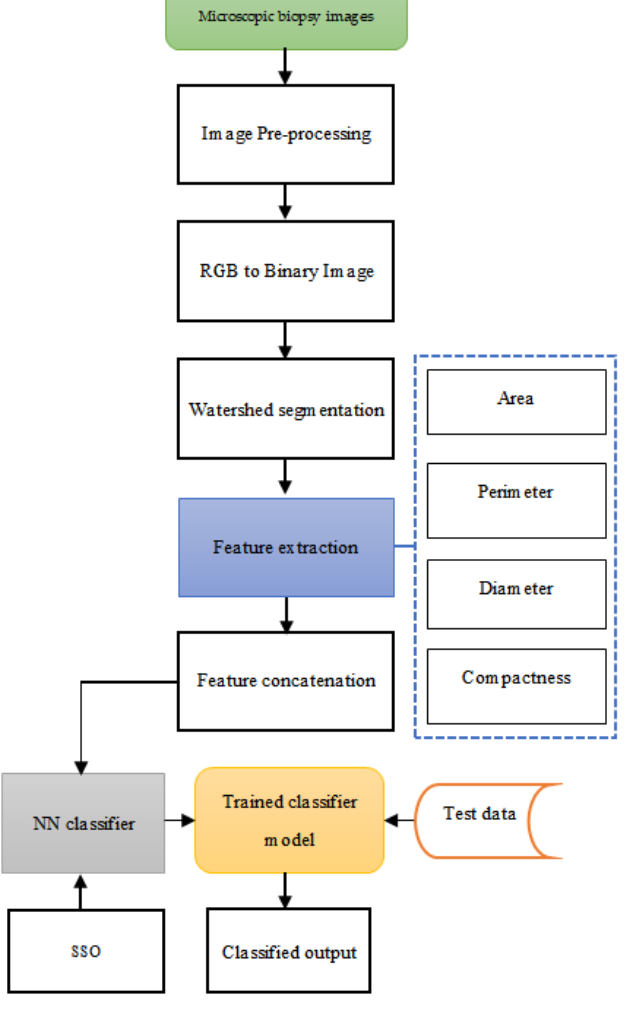
Figure 2. Schematic diagram of the proposed cancer disease diagnosis model.